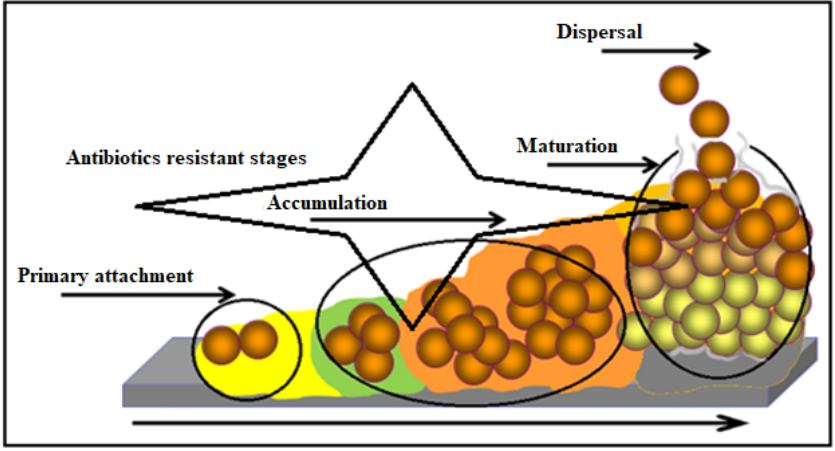
Figure 3. Model of biofilm progression showing distinct phases and microcolony structure. (Monroe [87].)